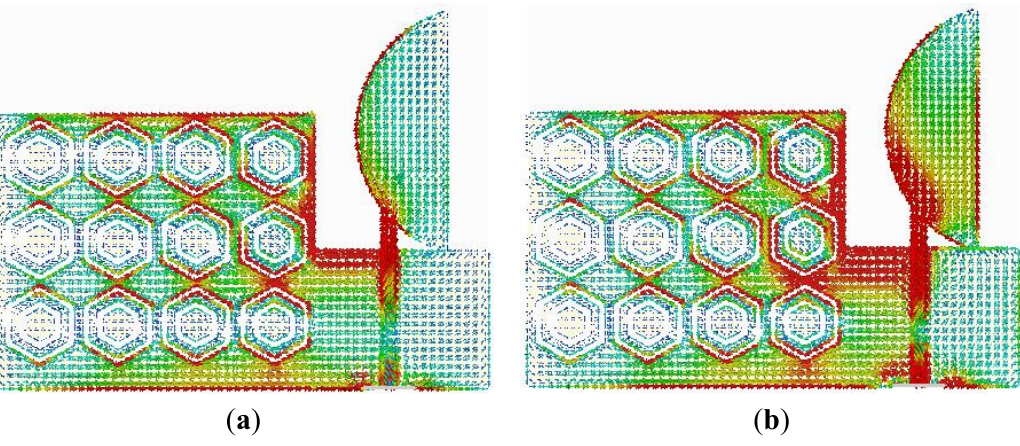
Figure 6. Surface current distribution of the proposed antenna at ( a ) 1.8 GHz; ( b ) 2.4 GHz.